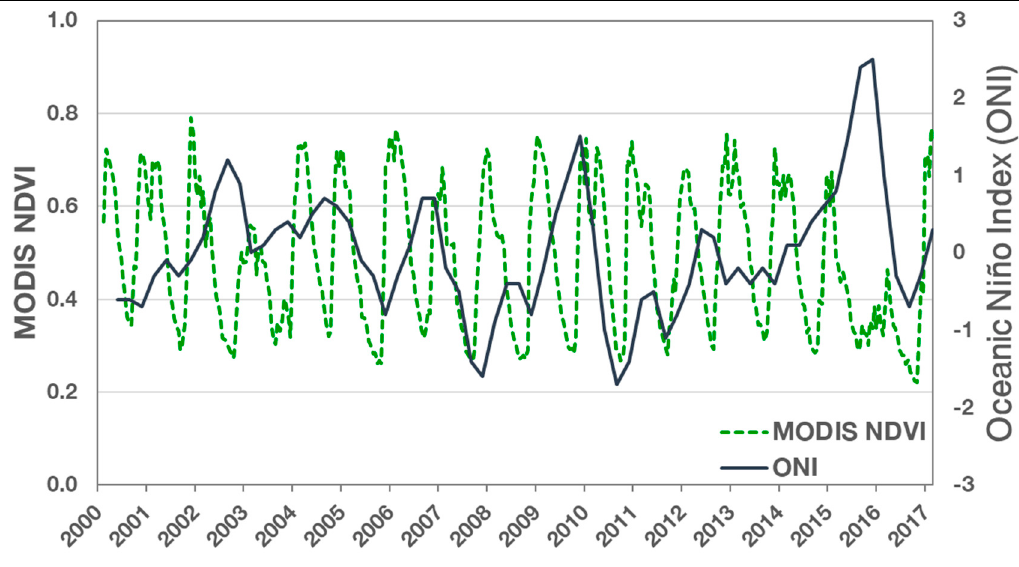
Figure 1. Moderate-Resolution Imaging Spectroradiometer (MODIS)-normalized difference vegetation index (NDVI) time series of the area (10 km × 10 km) around the Skukuza flux tower (25°1.184 ′ S, 31°29.813 ′ E) and the oceanic Niño index (ONI) [11,12]. Note the significant decrease in NDVI during the meteorological drought of 2015/2016 in combination with the occurrence of an extreme El Niño event.